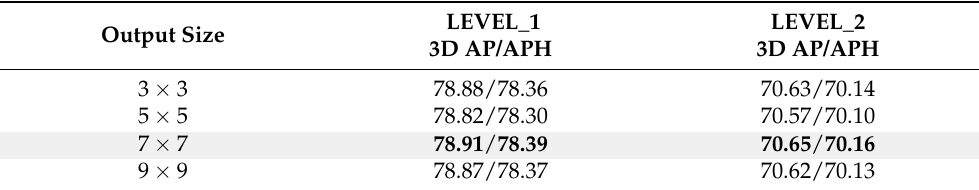
Table 8. Ablation on output size of RoI image features. the results are tested in the Waymo dataset with 202 validation sequences. The best results are bolded in the table.